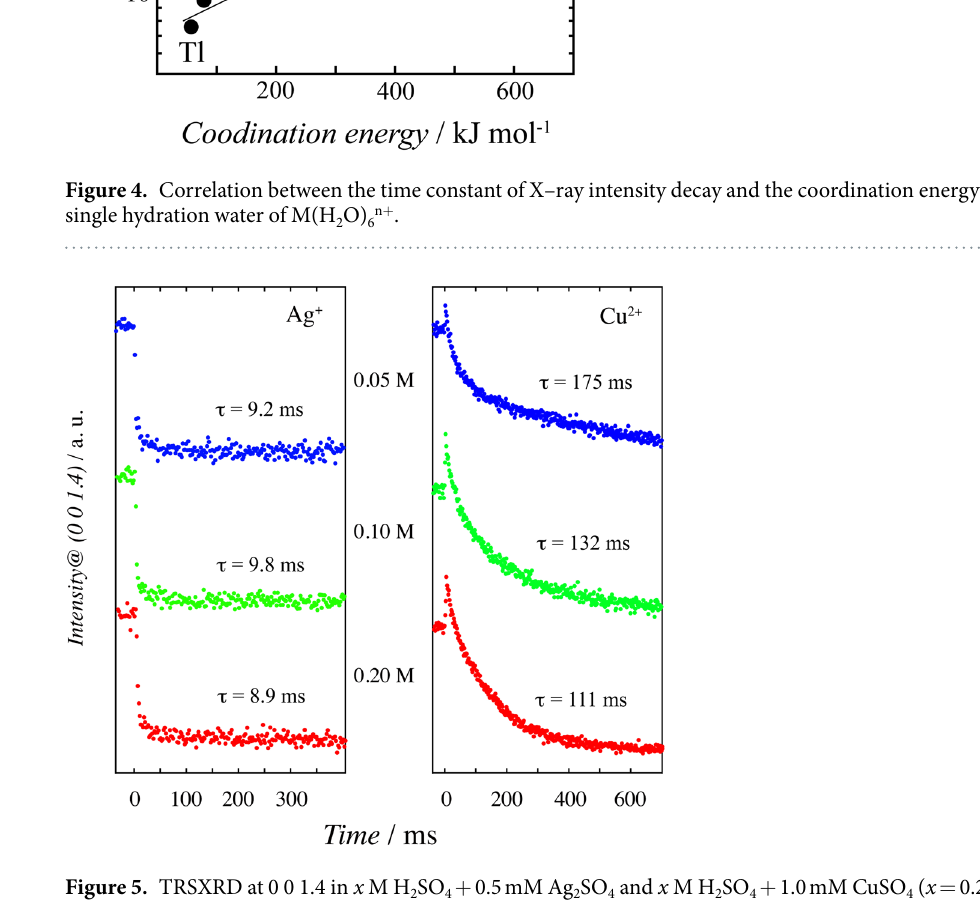
Figure 5. TRSXRD at 0 0 1.4 in x M H 2 SO 4 + 0.5 mM Ag 2 SO 4 and x M H 2 SO 4 + 1.0 mM CuSO 4 ( x = 0.20 (red), 0.10 (green), and 0.05 (blue)) with the time resolution of 1.0 ms. The pH of all of the solutions is adjusted to be the same as that of 0.5 M H 2 SO 4